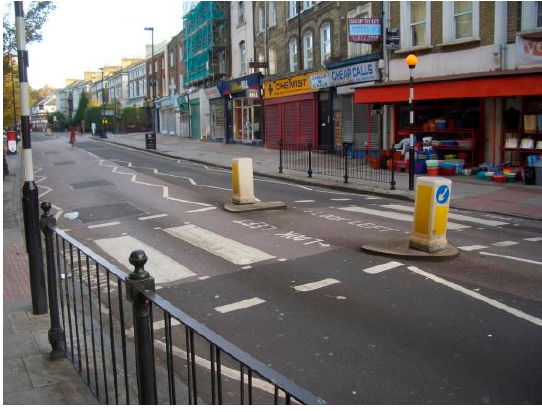
Figure 1. An example of footway crossing and its entry points. Photo credit: OpenStreetMap Wiki.